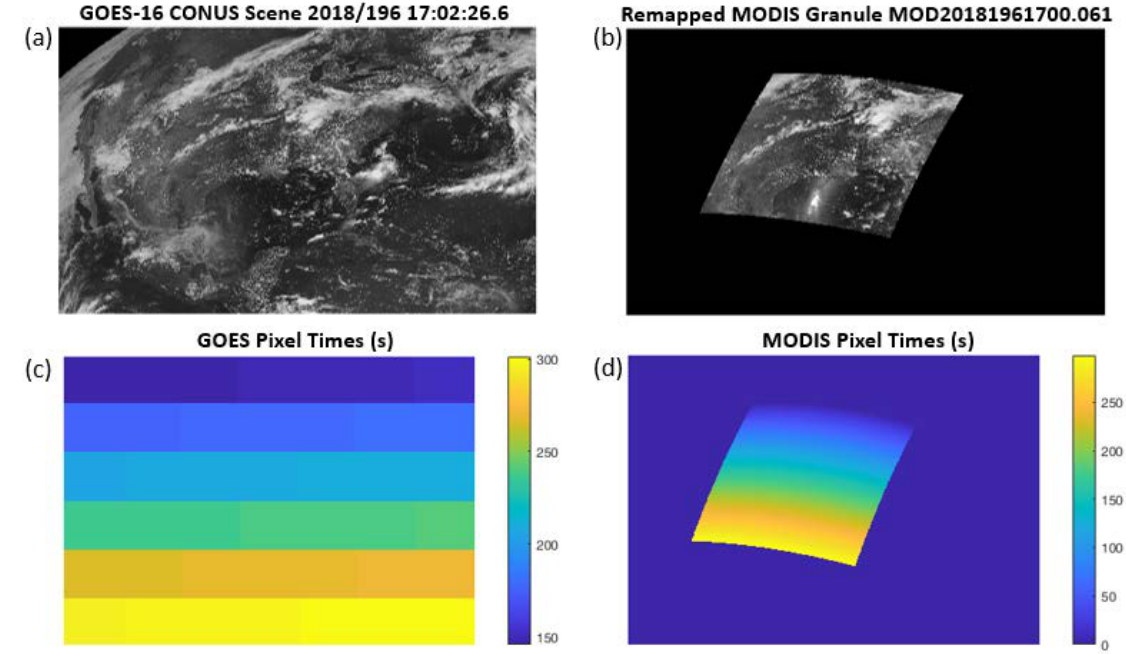
Figure 3. MODIS radiances are remapped along with their time tags to form fixed-grid mosaics in the same geometry as GOES ABI. An ABI scan model provides the time tags for the ABI pixels in each scene. At the upper left ( a ) is the B02 GOES-16 cloud and moisture imagery (CMI) for the CONUS scene and at the upper right ( b ) is the matching MODIS granule remapped to the ABI fixed grid. Their respective time models are shown on the bottom row ( c , d ). A common time epoch is used, which is the time of the first center-of-scan in the MODIS granule (about one second after the granule’s product time in this case). The case shown is MODIS granule MOD2018196.1700.061 (MODIS Band 1) paired with GOES-16 CONUS ABI Band 2.